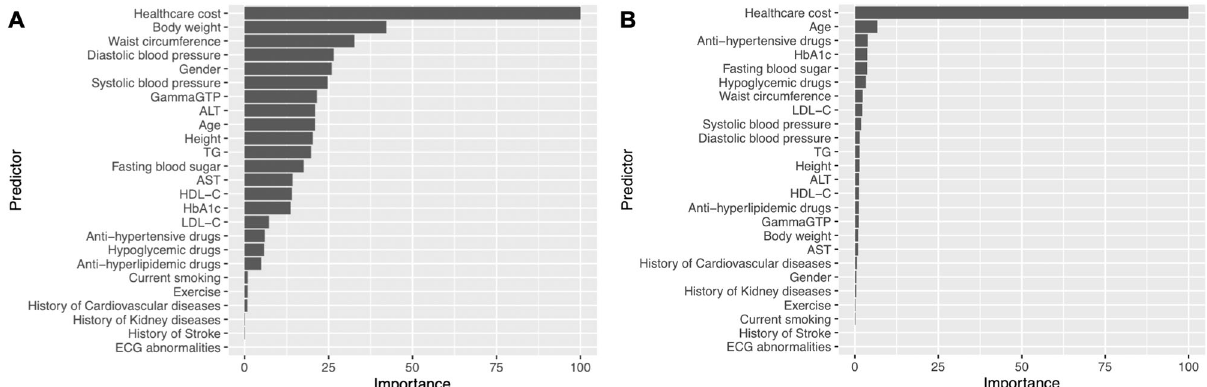
Fig. 3 Importance of each predictor in the random forest and gradient-boosted decision tree model. A The Random forest model. B The Gradient-boosted decision tree model. The variable importance is a measure scaled to have a maximum value of 100. HbA1c hemoglobin A1c, TG triglycerides, LDL-C low-density lipoprotein cholesterol, HDL-C high-density lipoprotein cholesterol, AST aspartate aminotransferase, ALT alanine aminotransferase, GammaGTP gamma-glutamyl transpeptidase, ECG